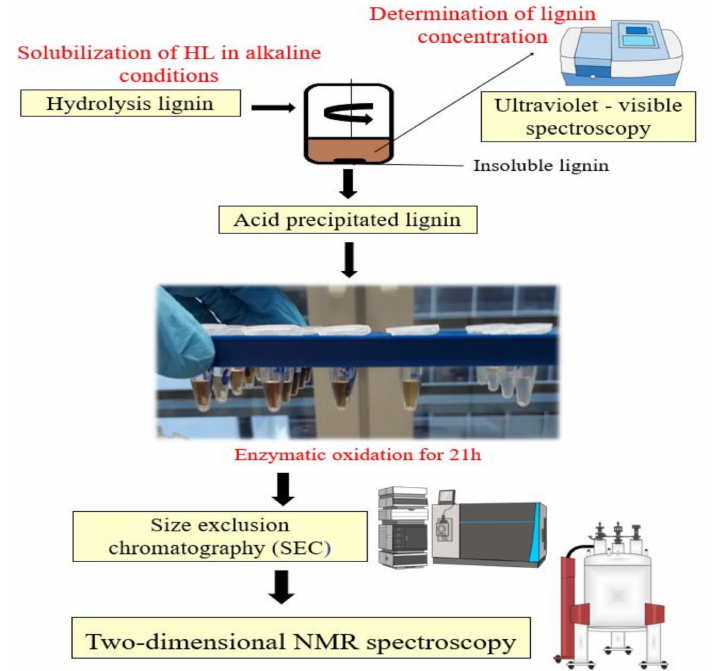
Figure 1. Preparation of APL, enzymatic oxidation reactions, and the characterization